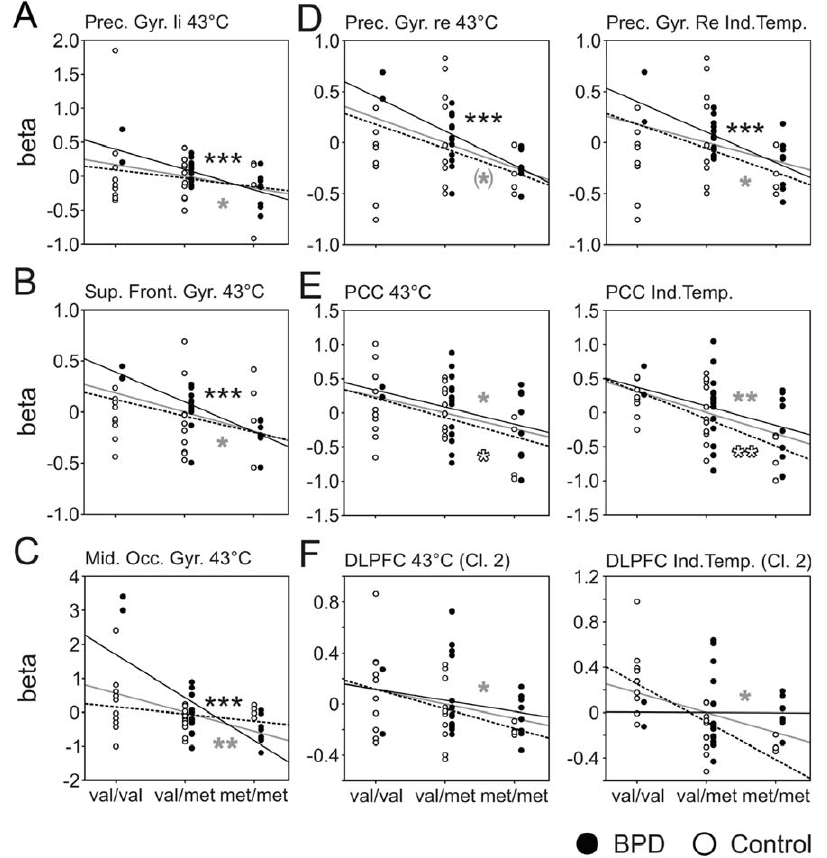
Figure 5. Association between COMT genotype and fMRI activation during painful stimulation in additional brain areas. (A) Left precentral gyrus, (B) Superior frontal gyrus, (C) Middle occipital gyrus, (D) Right precentral gyrus, (E) Posterior cingulated cortex, (F) Dorsolateral prefrontal cortex. Statistics and regression lines for group means are shown in gray (all 50 subjects), black (BPD), and dashed (Control), respectively; significant Pearson product moment correlation * p , 0.05, ** p , 0.01, *** p , 0.001, versus r=0.